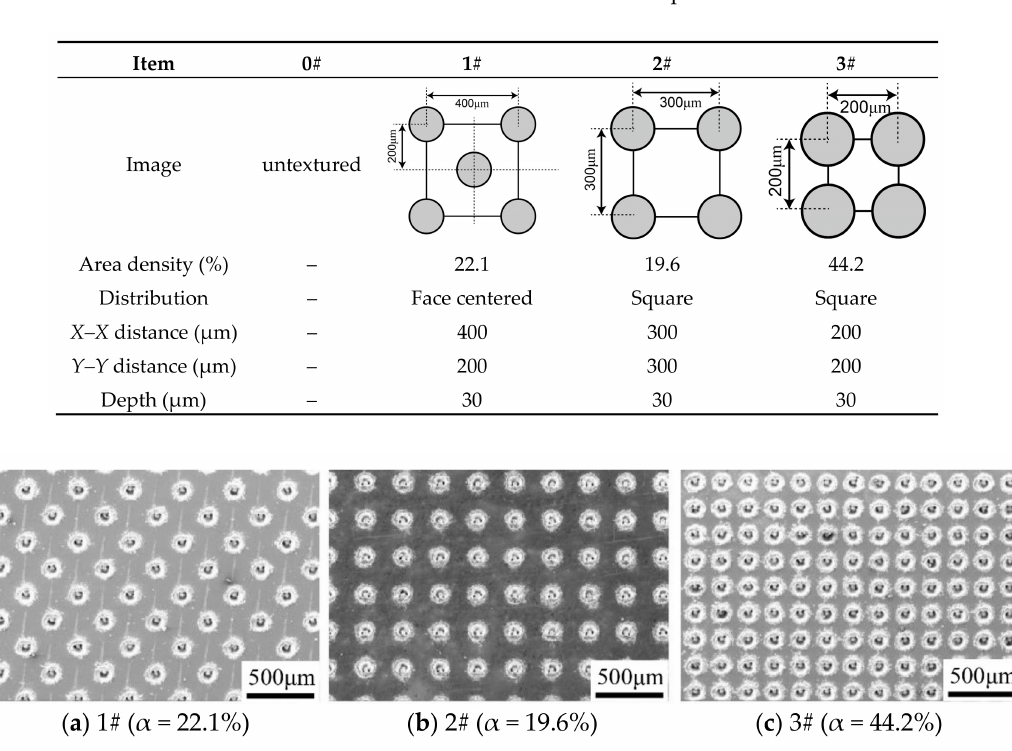
Table 2. Parameters of the textured samples.